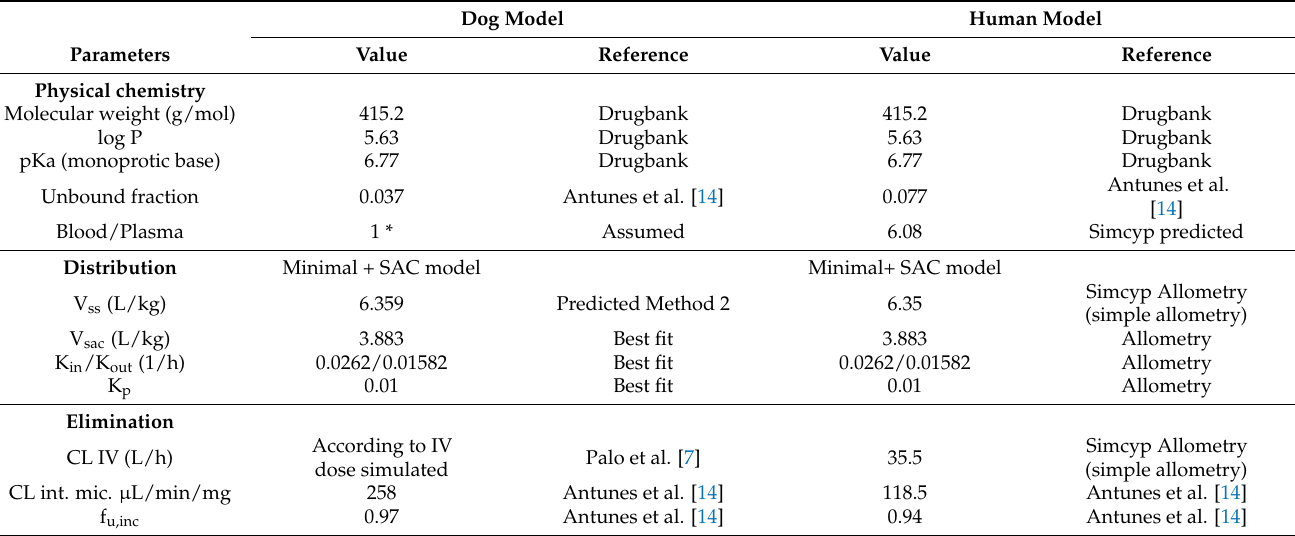
Table 4. Input parameters for the dapaconazole PBPK model in dogs and